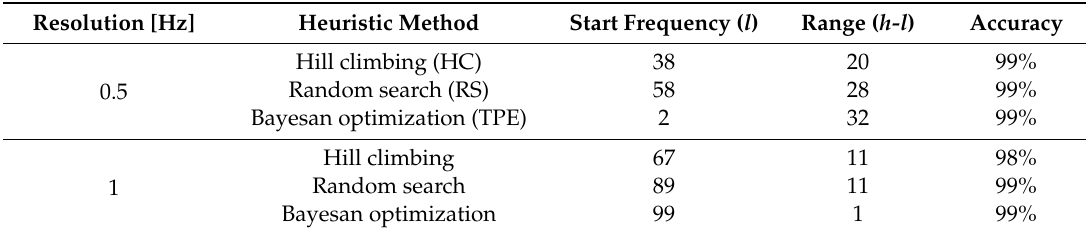
Table 2. The best solutions for heuristic methods.